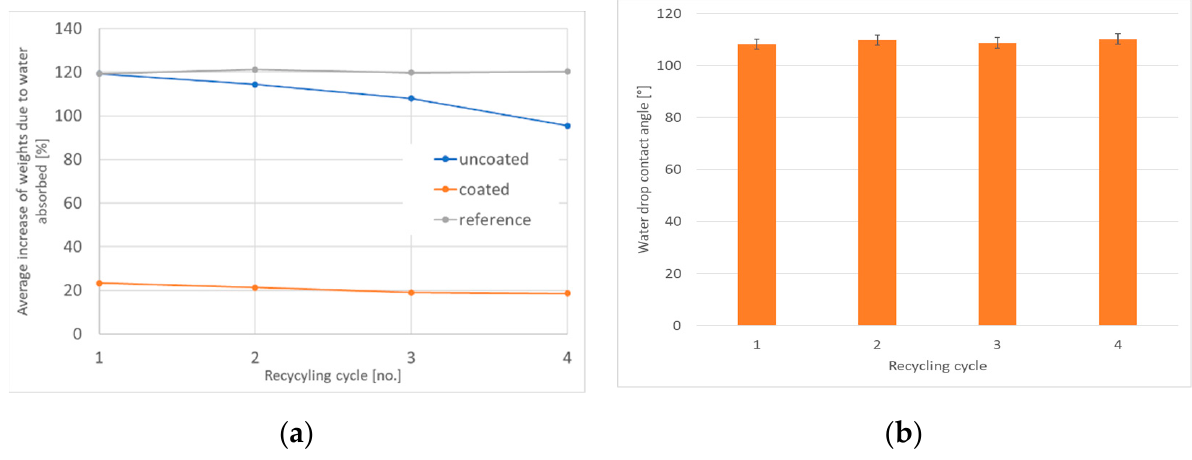
Figure 5. ( a ) Average increase in weights due to water absorbed (%) (Cobb 120 s) measurements for coated and uncoated samples, ( b ) average water contact angles for coated samples formed in 4 repeated cycles.